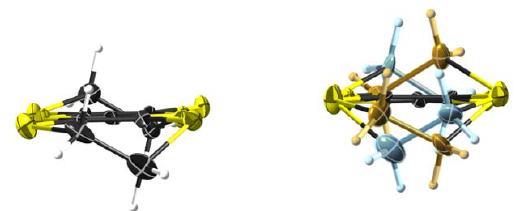
* 1a = 100 K (triclinic), 1b = 150 K (monoclinic), 1c = 240 K (monoclinic); # severe disorder that is unable to be evaluated due to the low quality of the crystal; $ second value is for molecule C; & second value is for molecule D.